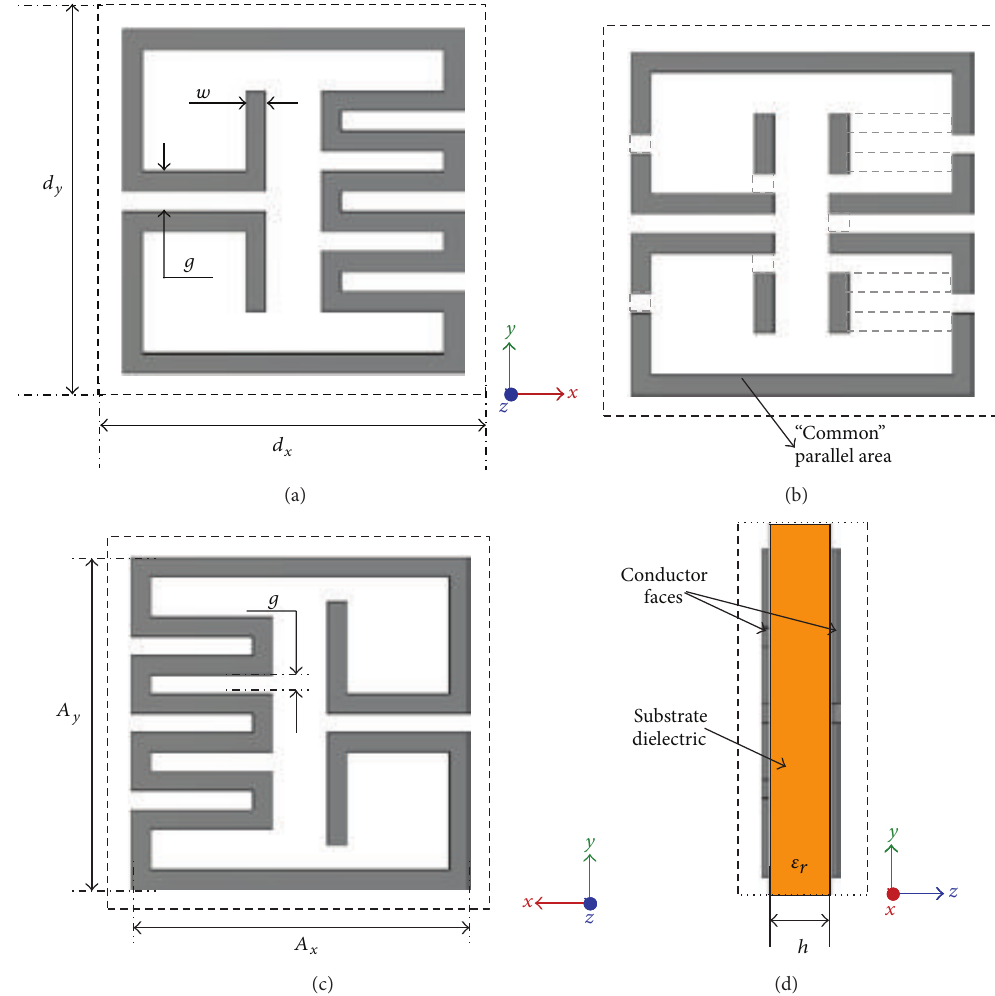
Figure 3: New FL-LHM unit-cell structure for resonant frequency at 5.8 GHz: (a) front view of FL-LHM unit-cell; (b) “common” parallel area of unit-cell; (c) back view; (d) side view. The details of parameters are summarized in Table 2.